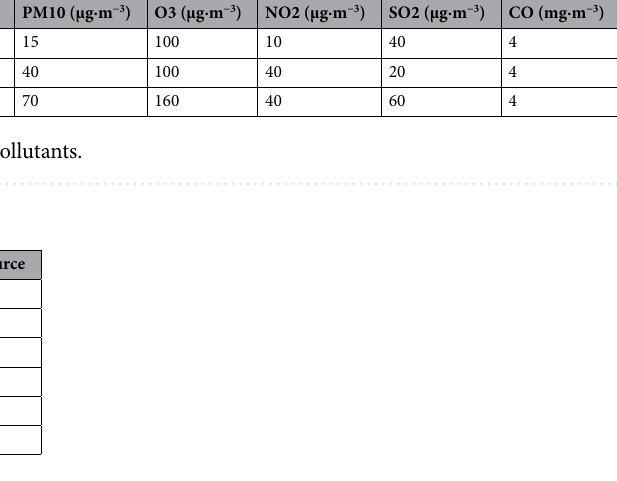
Table 7. Percentage increase in the population mortality due to excessive pollutant concentrations.